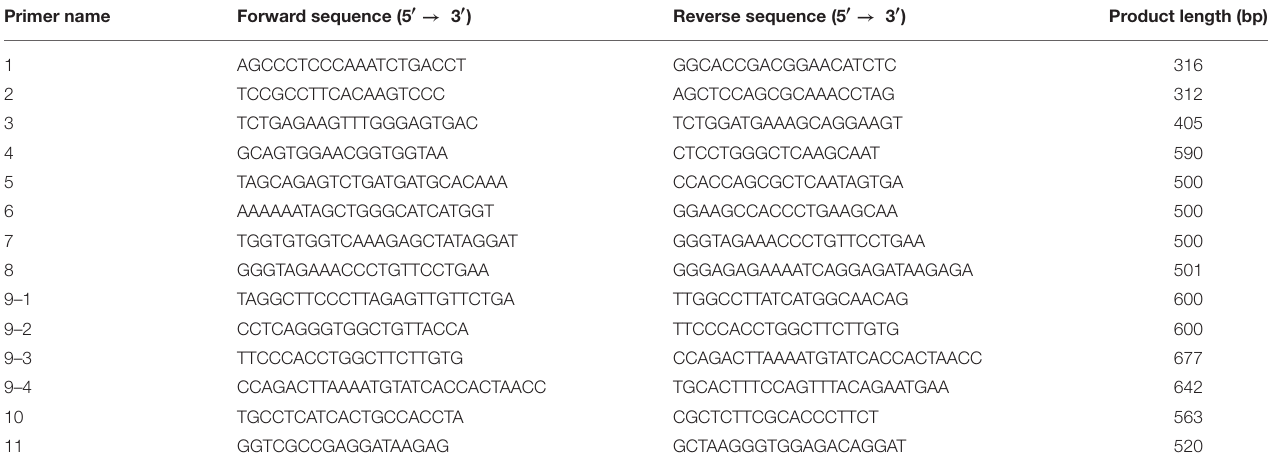
TABLE 2 | The primer sequences of all exons of DUOXA1